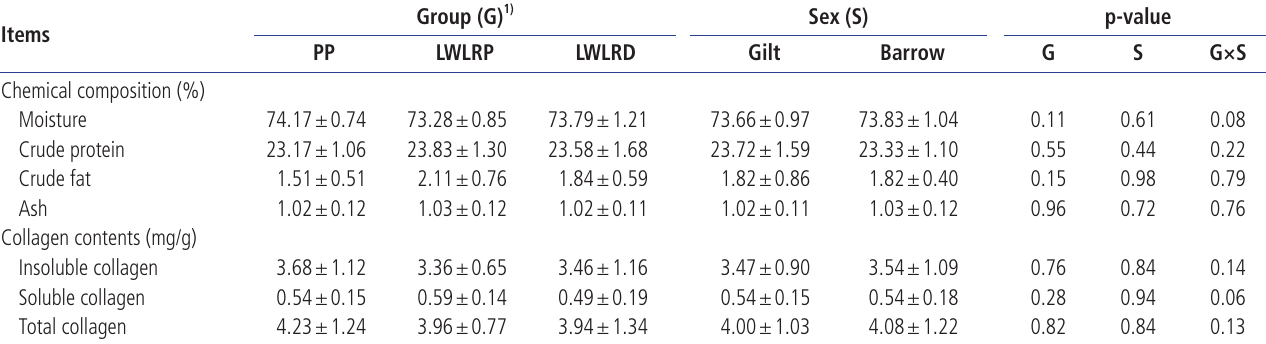
Table 4. Means±standard deviation of chemical composition and collagen contents of Longissimus muscle from finished Pakchong 5 pig and crossbred pigs sired by Pakchong 5 or Duroc boar Items Chemical composition (%)